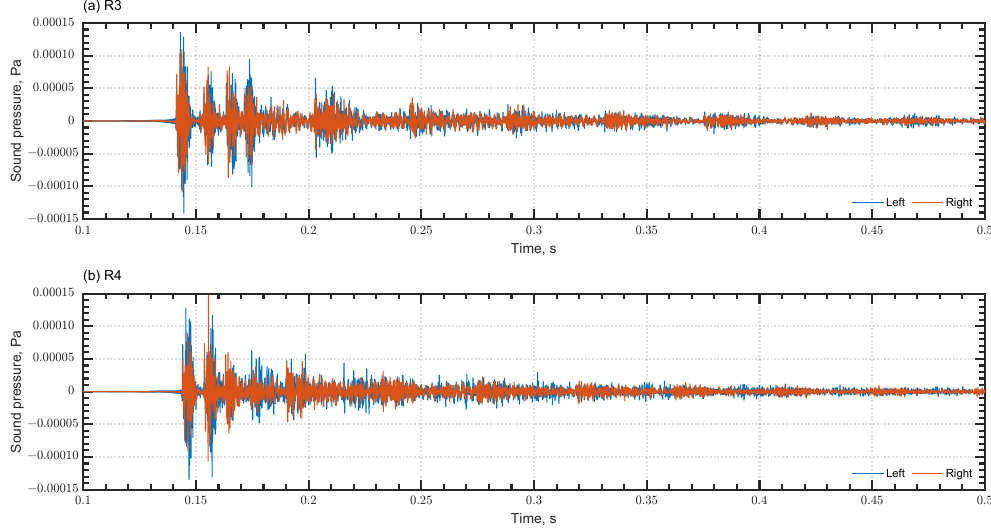
Figure 15. BRIRs for Cond. 1 at ( a ) R3 and ( b )